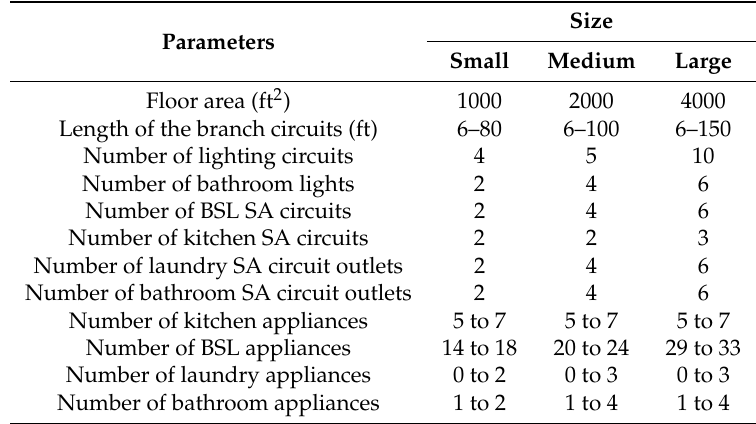
Table 3. Parameters for the Three House Sizes.